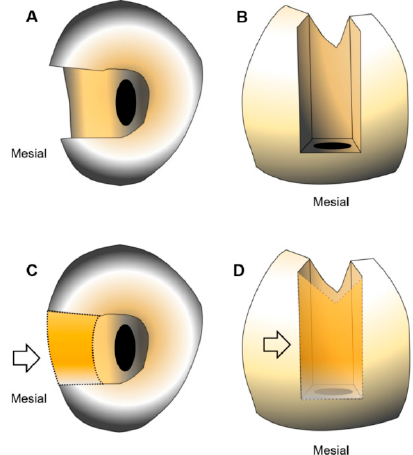
Figure 1. Representative picture of occlusal ( A , C ) and mesial ( B , D ) view of mandibular first premolars without ( A , B ) and with ( C , D ) pre-endodontic restoration. The orange dotted line indicates the mesial composite wall (arrows).